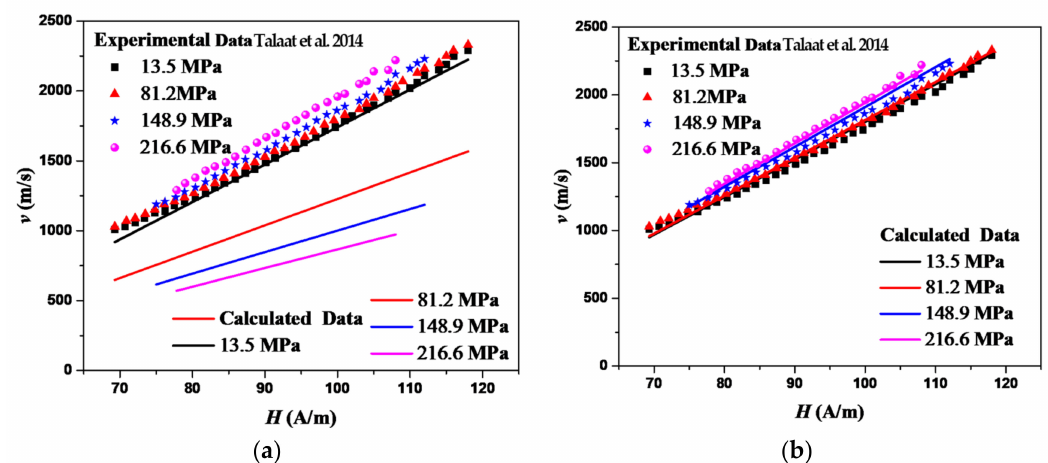
Figure 3. The predictions of DW velocity on magnetic field measured for Co 69.2 Fe 4.1 B 11.8 Si 13.8 C 1.1 microwires [28] under different tensile stresses based on the linear ME. (Reproduced with permission from IEEE Transactions on Magnetics 50, 1–4 (2014). Copyright 2022 IEEE) ( a ) and the proposed non- linear ME ( b ). The following parameters are used in the calculation: K 0 = 8 J/m 3 , A / a = 1800 J/m, λ s 0 = 1 × 10 − 7 , H 0 = 35 A/m, ϑ / G = 3.1 × 10 − 8 Pa − 1 , and v =